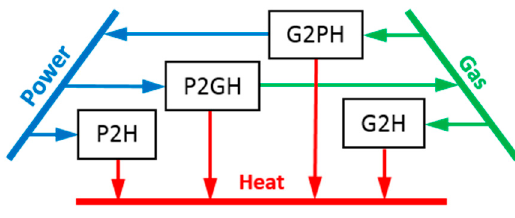
Figure 3. Implemented hybrid elements in HyFlow.